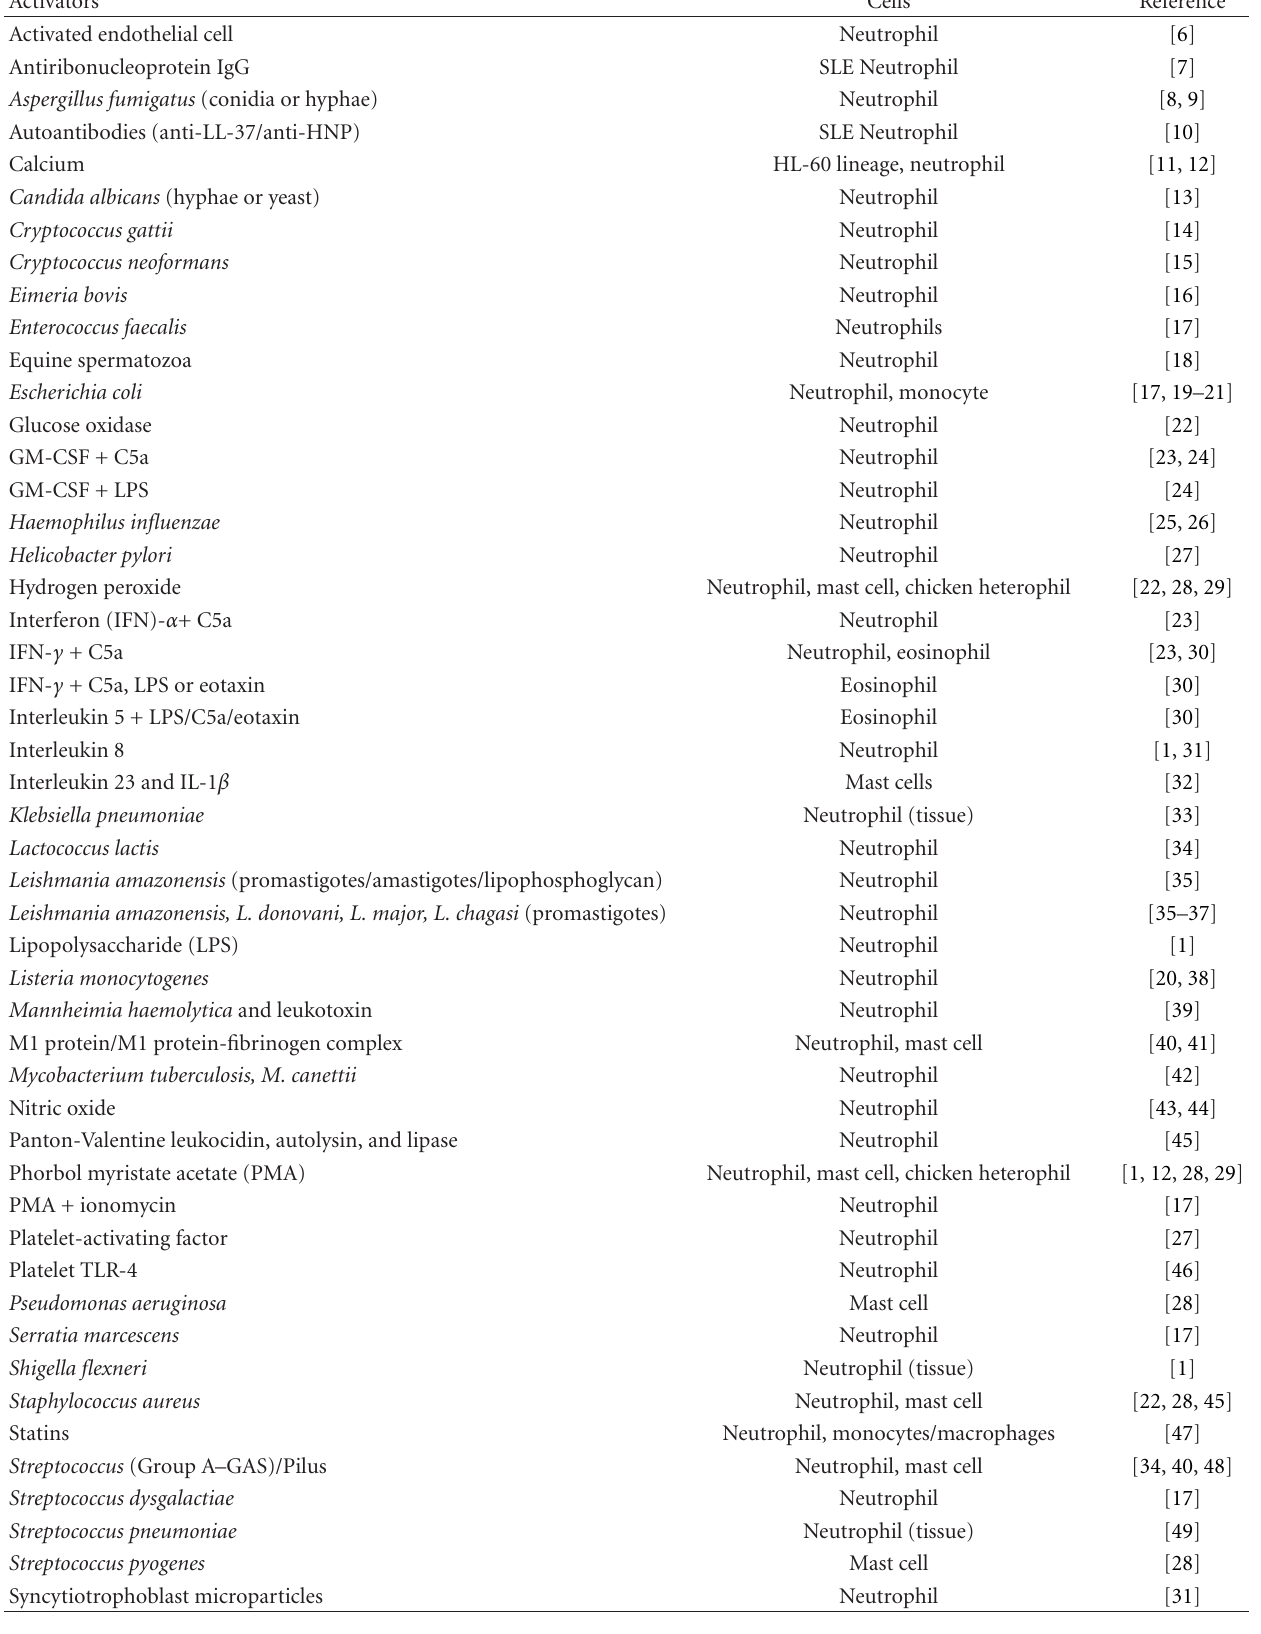
Table 1: Microorganisms or molecules able to trigger extracellular traps